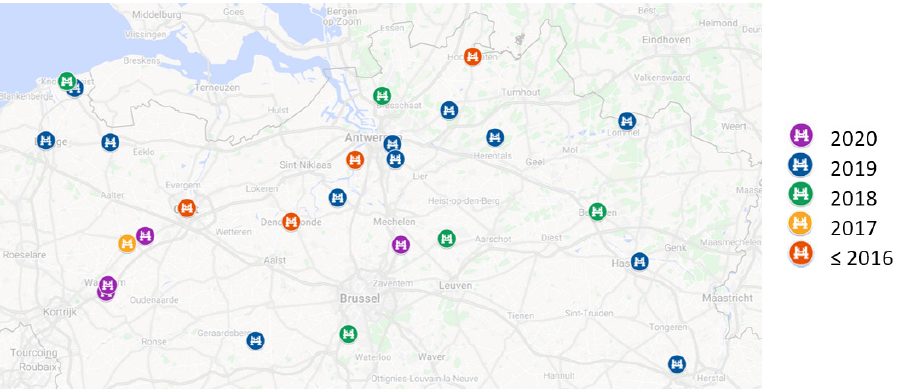
Figure 1. FRP bridges in Flanders from 2010 to 2020.